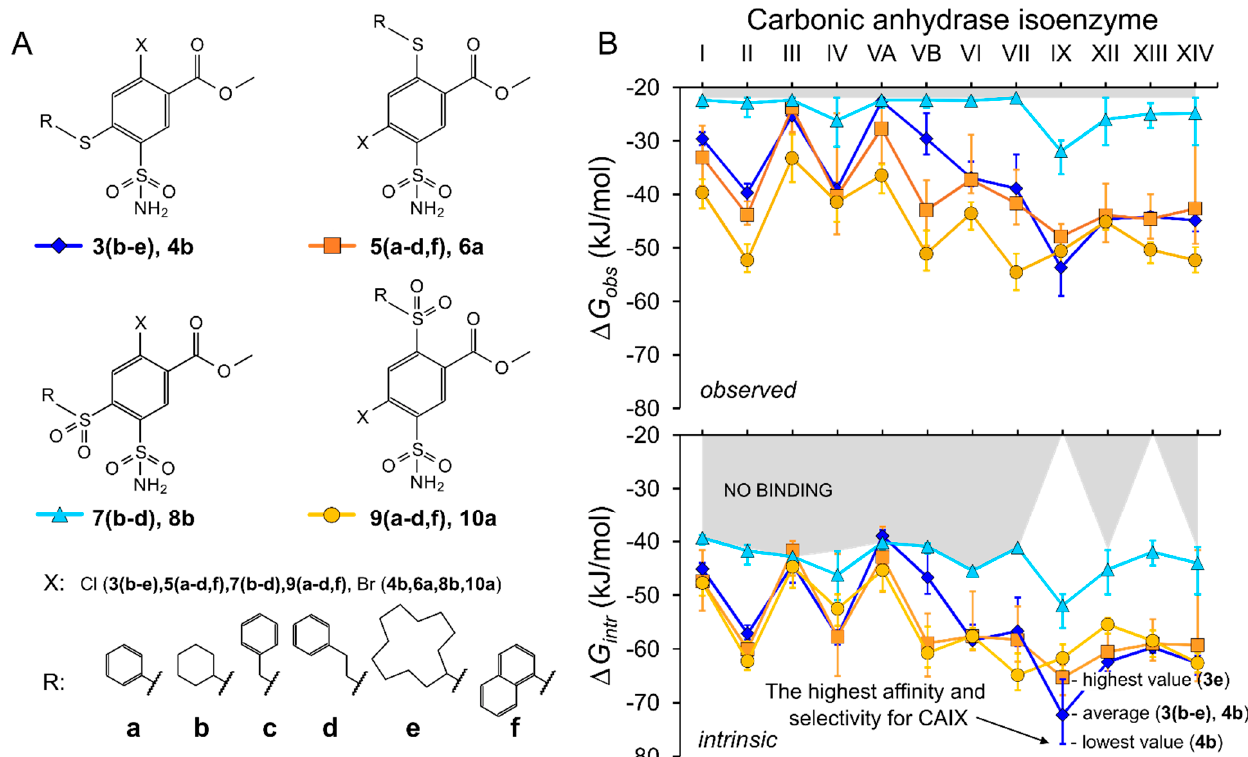
Figure 1. ( A ) Chemical structures of the four groups of compounds—methyl halo 2- or 4-substituted-5-sulfamoyl-benzoates containing chlorine or bromine and substituents listed at the bottom of the panel. ( B ) Averaged change in the standard observed (upper panel) or intrinsic (lower panel) Gibbs energy for compounds belonging to one of the four groups: 3 ( b – e ), 4b —blue rhombs, 5 ( a – d , f ), 6a —orange squares, 7 ( b – d ), 8b —cyan triangles, and 9 ( a – d , f ), 10a —yellow circles. The bars show the margin between the strongest and weakest affinity of compounds in that group for the indicated CA isozyme. The intrinsic binding affinity of compounds 3 ( b – e ), 4b to CAIX is highlighted: the blue rhombus is the average of all five interactions, the bar above shows the weakest CAIX interaction with 3e , and below is the strongest with 4b . Compounds in this group have the highest selectivity and affinity for CAIX.